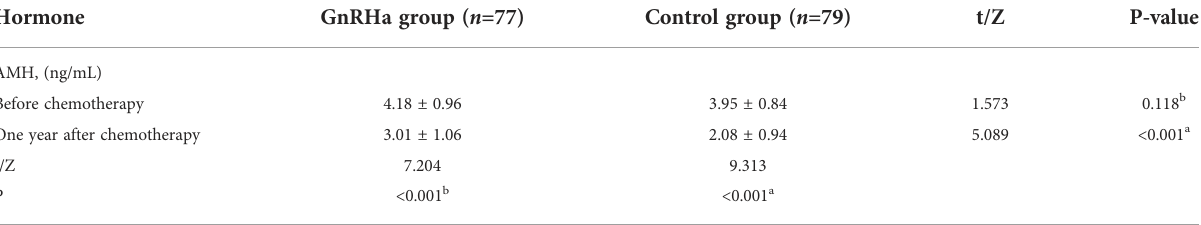
TABLE 2 AMH levels of the two groups before chemotherapy and one year after chemotherapy (x ± s). Hormone